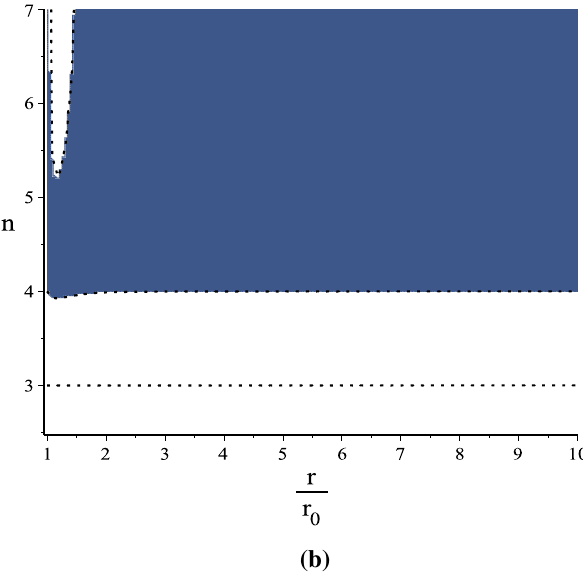
beyond it. In the blue region of b , F < 0 and (18) are simultaneously satisfied,sothisregionshowstraversableasymptoticallyflatwormholes of the Tsujikawa model, that respect the WEC. In these figures we set μ = 1 . 02 , R ∗ = 0 . 1 and r = 0